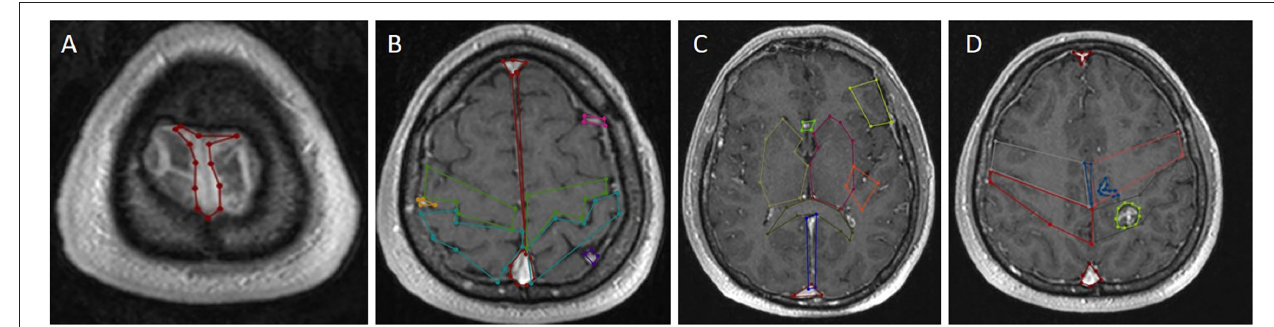
FIGURE 3 | Labeling using contrast-enhanced T1 axial image of cranial MRI. (A) Superior sagittal sinus marked in red at the vertex’s midline. (B) Superior sagittal sinus marked with red in the midline in the supraventricular area, precentral gyrus marked with green, postcentral gyrus marked with turquoise, superficial cortical veins marked with pink on the left and dark yellow on the right adjacent to the bilateral frontal lobes. (C) Right basal ganglia and thalamus marked with yellow in the right cerebral hemisphere at the ventricular level; left basal ganglia and thalamus marked with light red in the left cerebral hemisphere at the ventricular level, Broca’s area in the left frontal lobe with light yellow, Wernicke’s area posterior to Sylvian fissure marked with orange; The anterior cerebral arteries are marked in light green anteriorly in the midline, the corpus callosum splenium in green and the sinus rectus in blue in the midline posteriorly. (D) Right postcentral gyrus marked red, cavernom/tumor marked yellow-green, pericallosal artery marked blue on the midline and posterior inferior frontal artery marked blue.